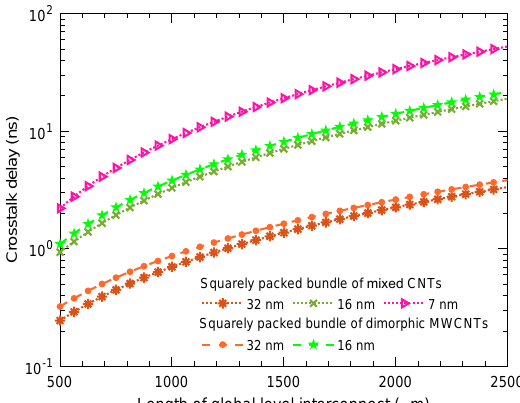
Figure 12. Comparative illustration of the crosstalk delay of the proposed and previously developed bundle configurations for different technology nodes at global-level interconnect lengths. The diameter and number of the used CNTs are the same as those used in the simulation for obtaining propagation delays at the global